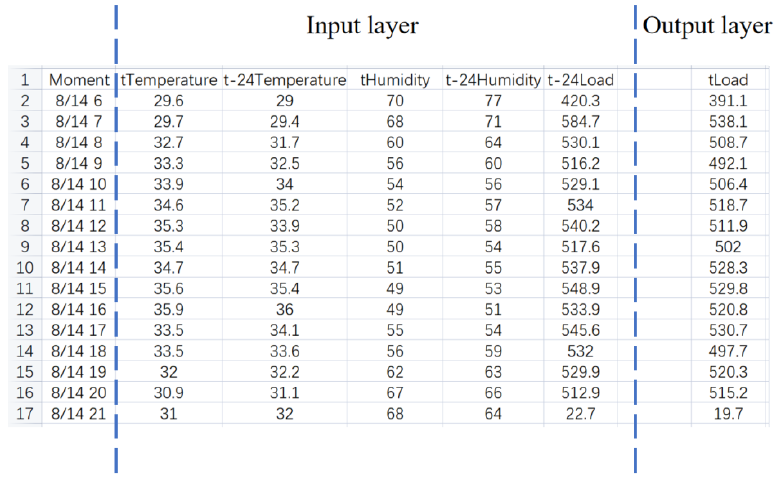
Figure 12. The input layer and output layer of the cooling load at the moment t .